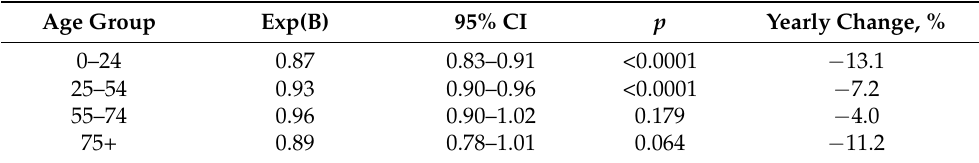
Table 1. Yearly changes of incidence of acute hepatitis C virus infection in different age groups,